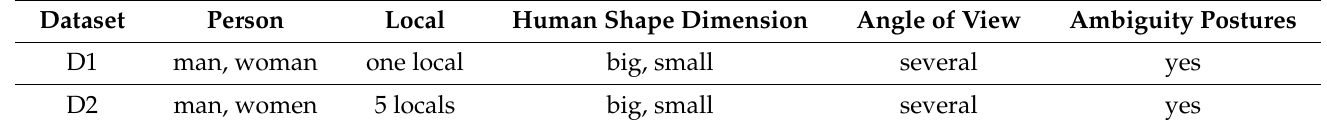
Figure 10. Posture samples from the Dataset D2. Columns 1–4 correspond to standing, sitting, lying and bending postures, respectively. Table 2. Characteristics challenge of each dataset.